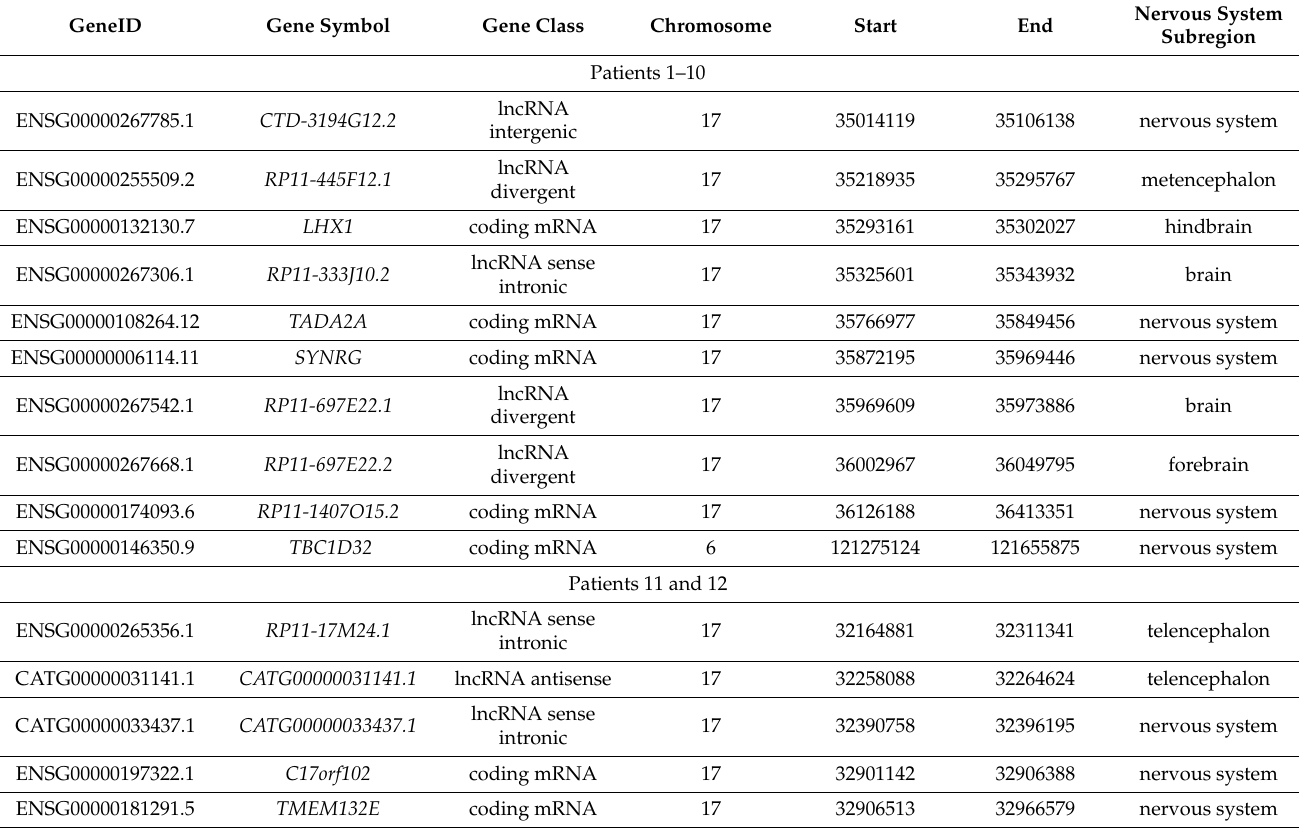
Table 2. Brain-enriched coding and long non-coding RNA genes in the described case